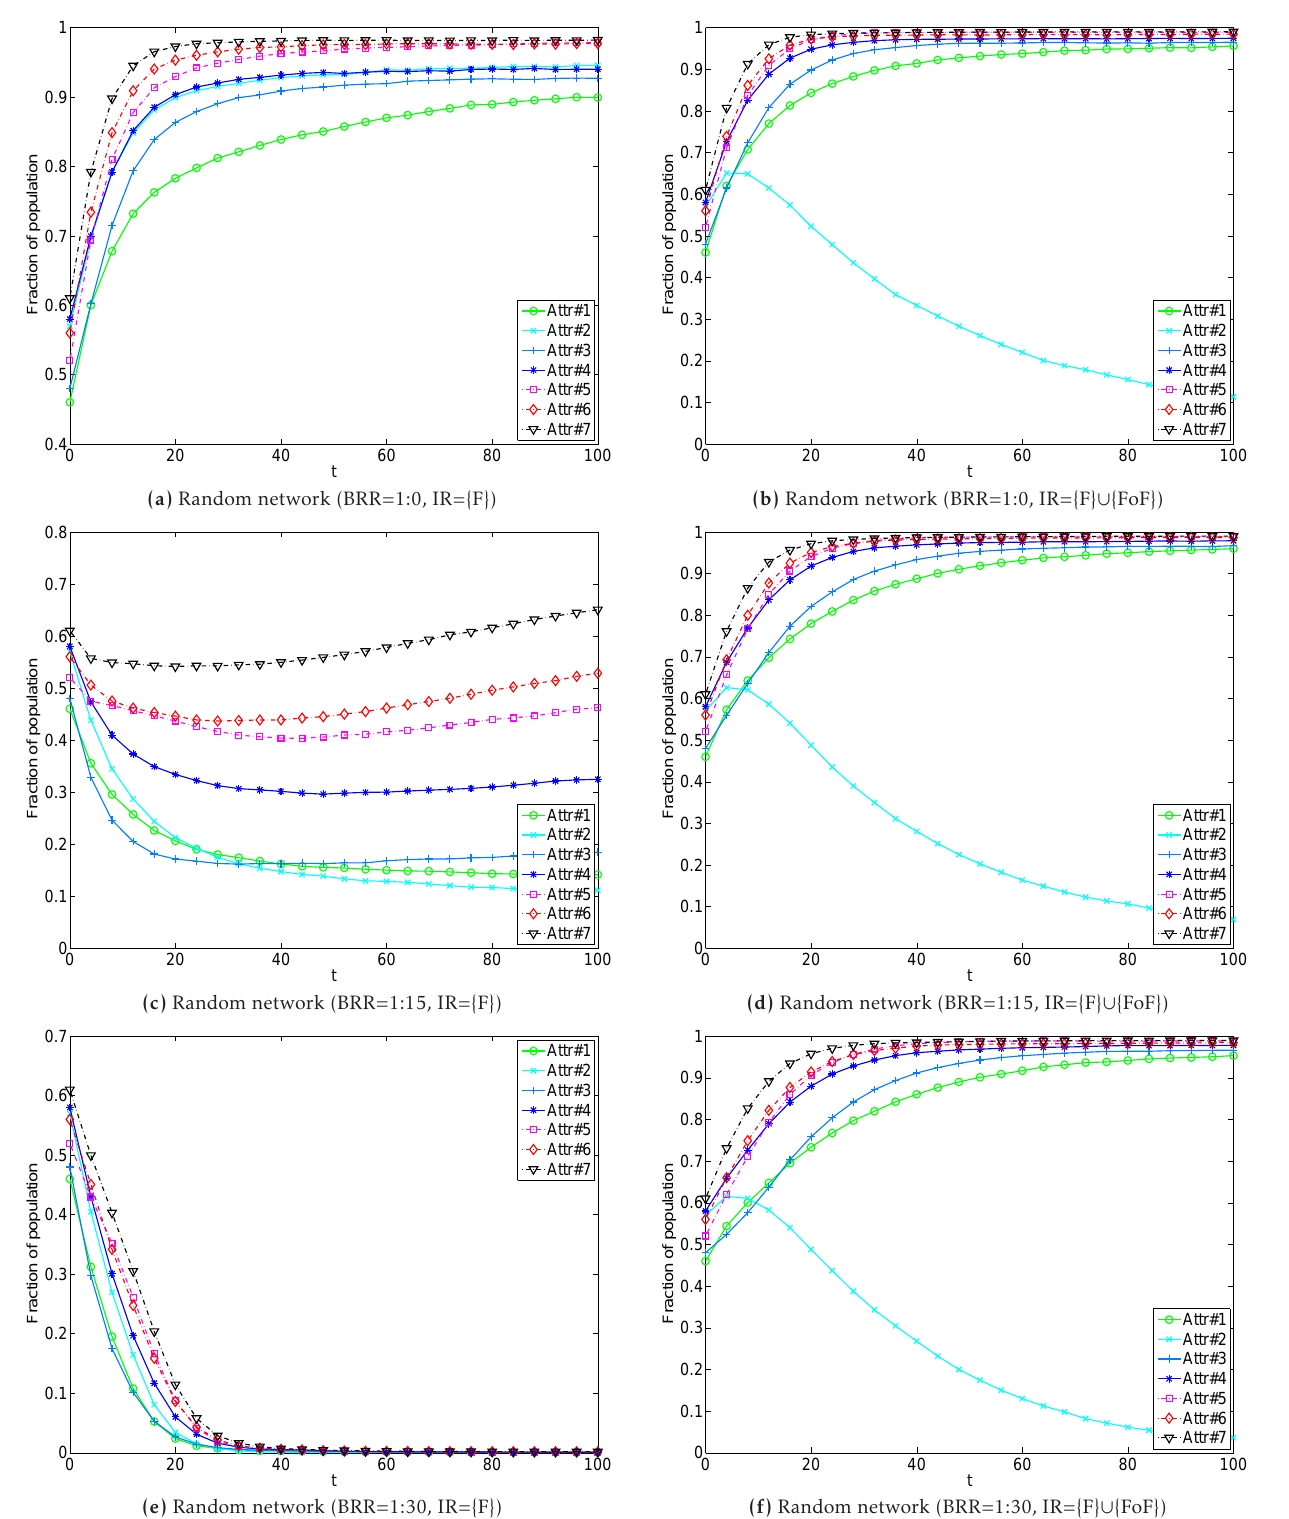
Figure 6. Attribute dynamics for the weighted evolutionary game in random network. The figures in left column correspond to applying Friends as the influential range of the utility